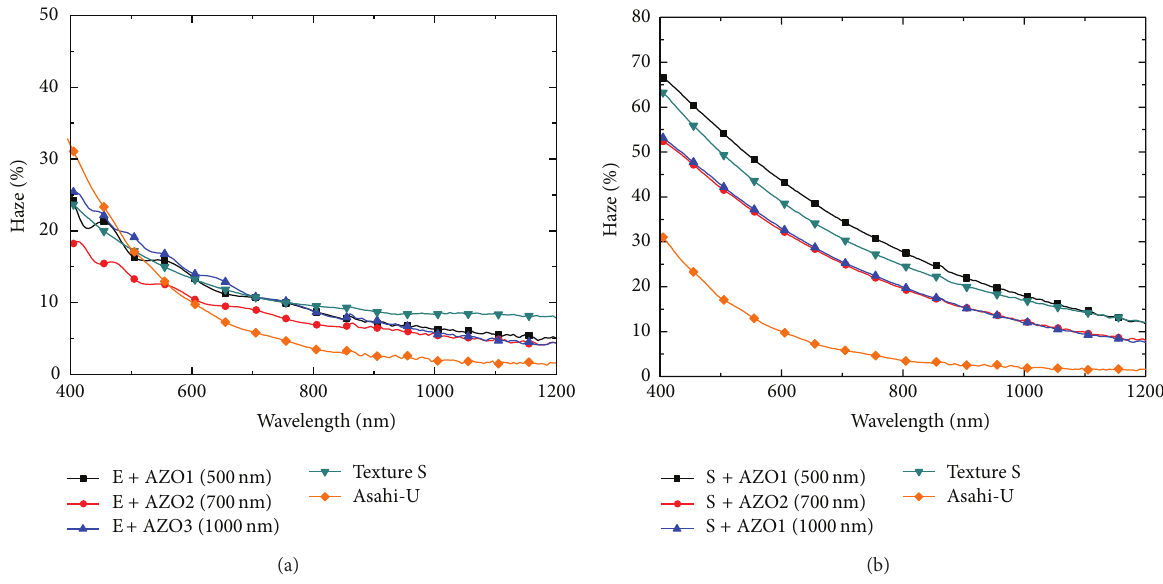
Figure 8: Haze values of the samples (a) texture E, texture E + three different AZO thicknesses, and Asahi-U substrate and (b) texture S + three different AZO thicknesses and Asahi-U substrate.